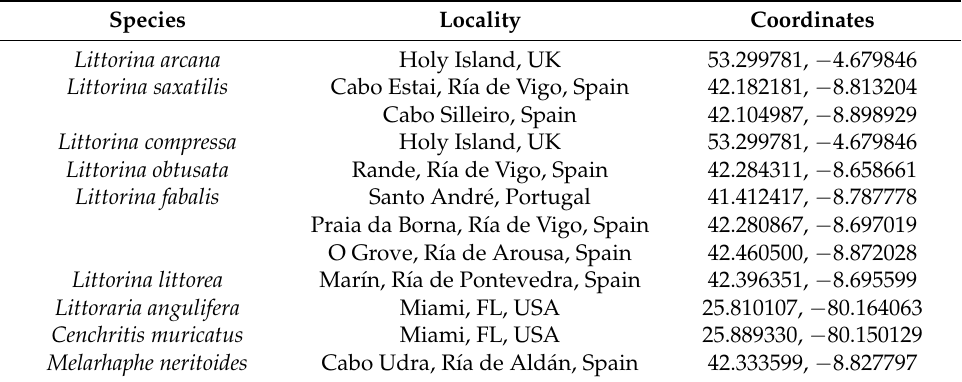
Table 2. Collection localities of the species of